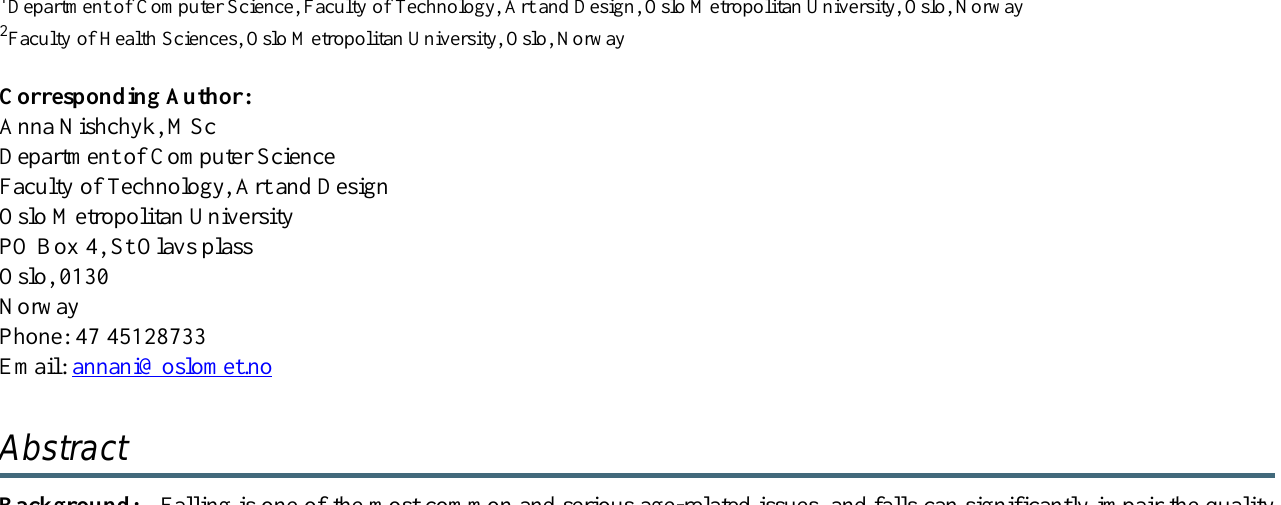
falls; fall prevention; mixed reality; augmented reality; virtual reality; physical